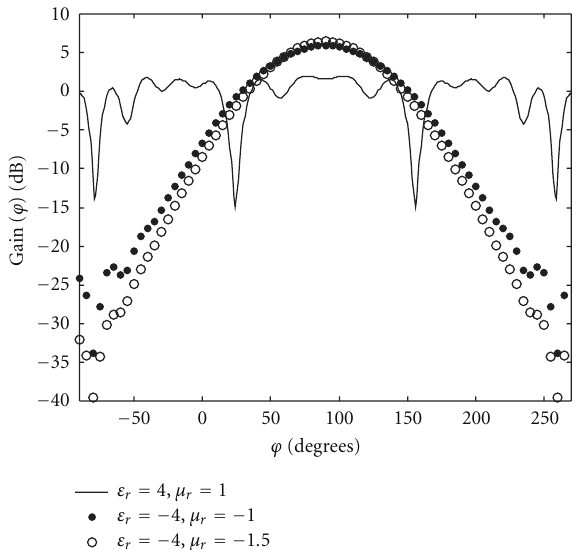
Figure 2: Radiation pattern of an axially slotted elliptic cylinder coated with conventional dielectric, magnetic and nonmagnetic metamaterials. a c = λ , b c = λ , a = b = b c + 0 . 25 λ , ν 0 = 90 ◦ , and α = 2 . 8657 ◦ .